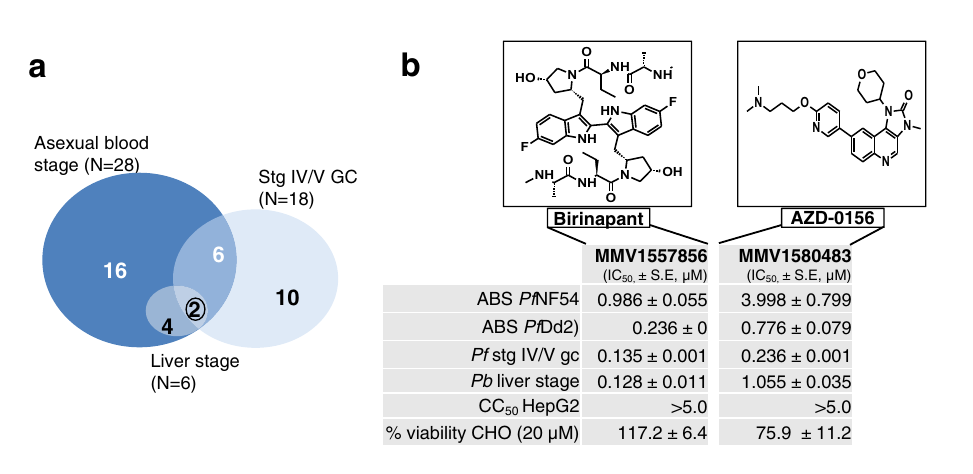
Fig. 3 Active compounds on multiple stages of Plasmodium development after dose – response evaluation and cytotoxicity fi ltering. a Venn diagram of the number of compounds identi fi ed with activity (inhibitory concentration, IC 50 ) below 2 µ M, for which no cytotoxicity was identi fi ed on either CHO cells (>50% viability at 2 µ M or selectivity index >10) or HepG2 cells (selectivity index >10). b A total of two compounds with activity against all life